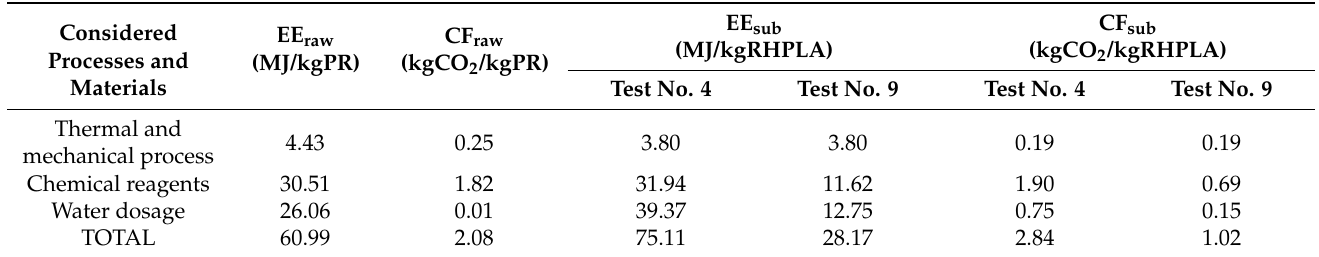
Table 5. Data results of the embodied energy (EE) and carbon footprint (CF) for the raw process (raw) and the new proposed process (sub) related to process 1 in the frame of ESCAPE study; it shows the comparison between the most efficient trial in terms of % P extraction (test no. 4) and the most sustainable trial (test no. 9) relative to the other trials. Considered Processes and Materials